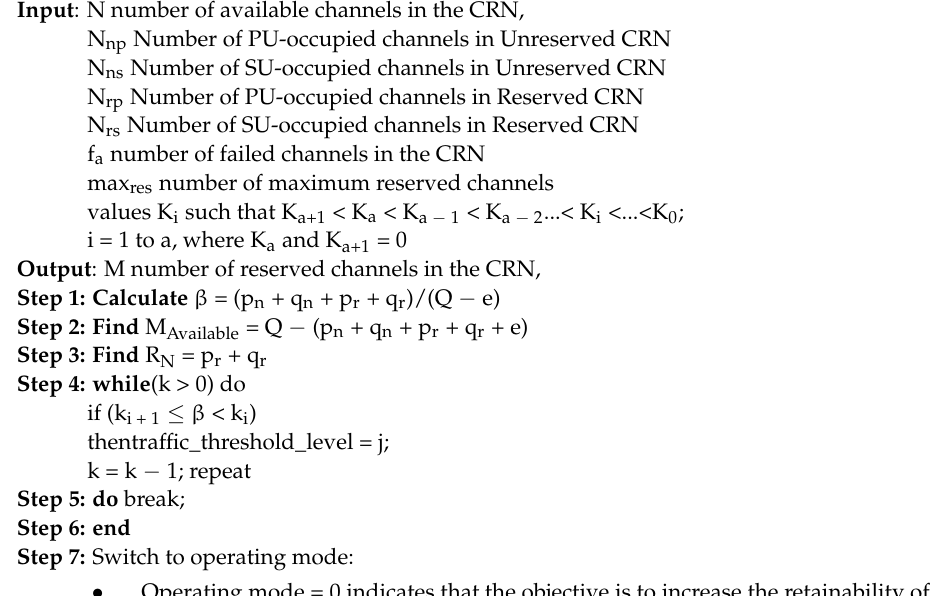
Algorithm 3. BENS Algorithm For Reservation